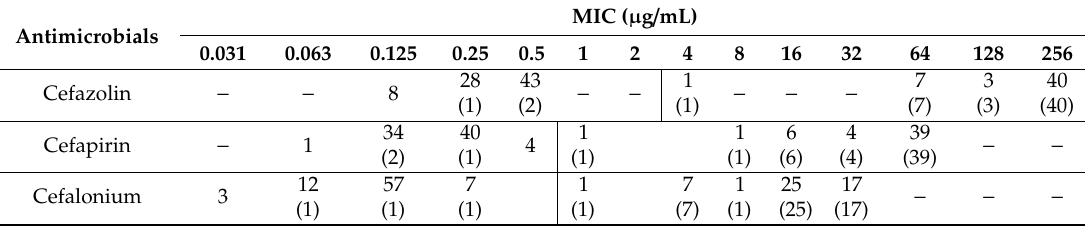
Table 1. The MICs of cefazolin, cefapirin, and cefalonium for 130 Staphylococcus aureus isolates from bovine mastitis.